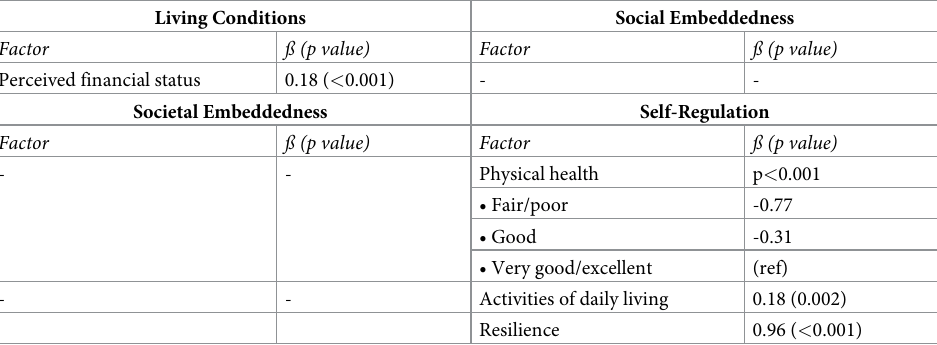
Table 6. NL final model: SQM factors that are independently associated with quality of life (R 2 =